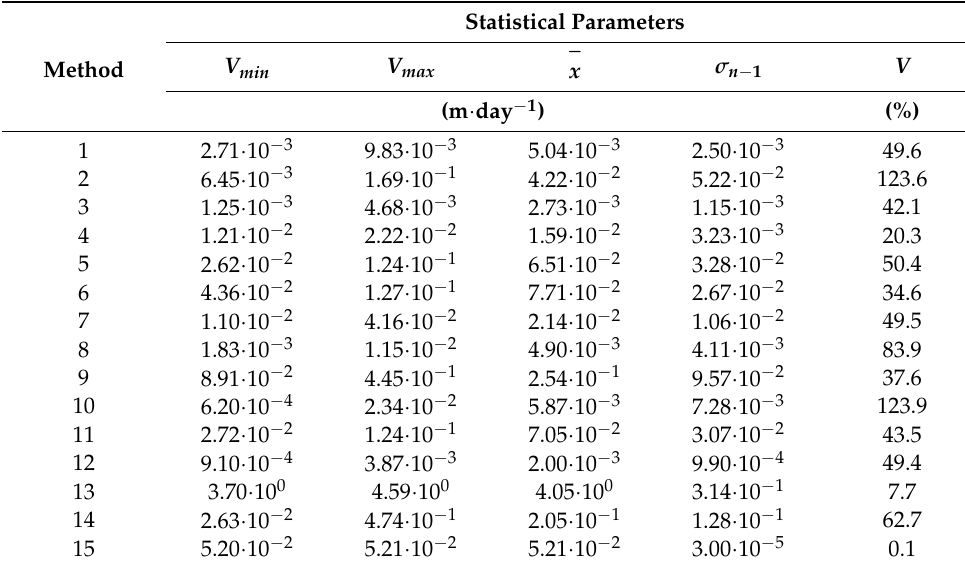
Table 3. Statistical parameters of the saturated hydraulic conductivity obtained for the chosenpedo- transfer functions.